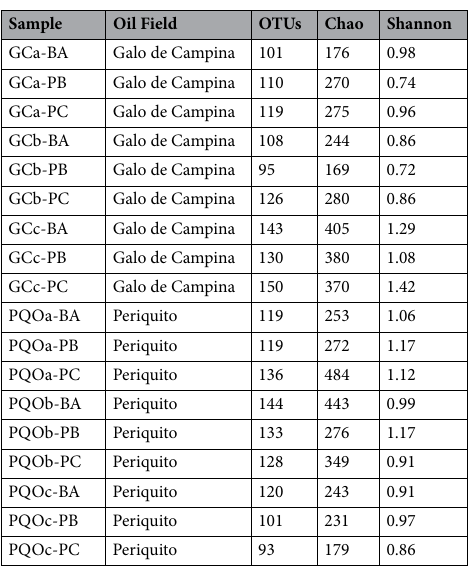
Table 1. Biodiversity of the Produced Water samples. BA = Baars medium, PB = Postgate B and PC = Postagate C; Galo de Campina oilfield (GC) and Periquito oilfield (PQO) a,b, and c sub-sample